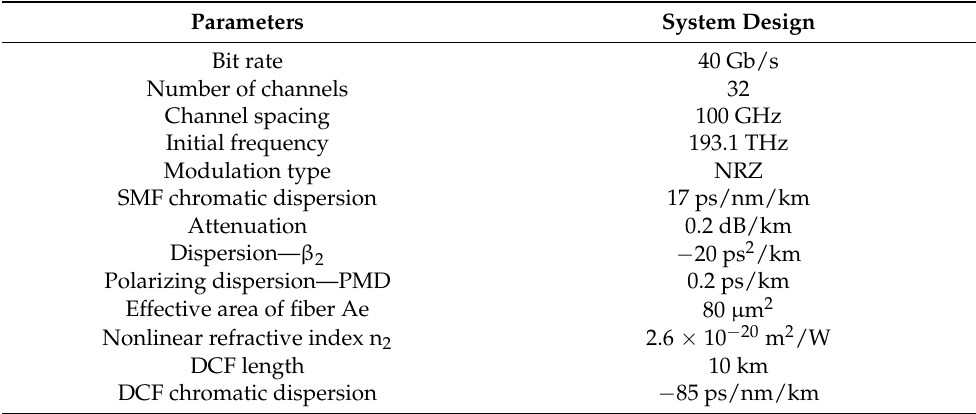
Table 7. Stable parameters for all optical schemes.